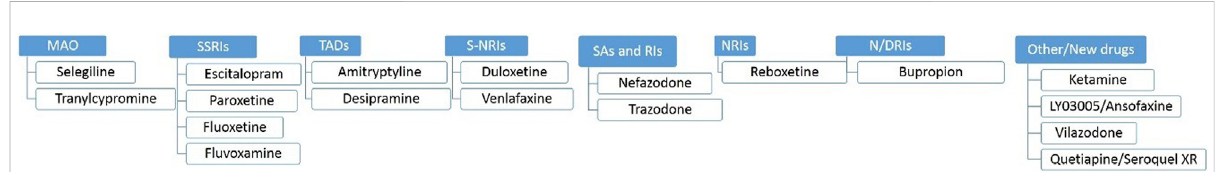
FIGURE 2 Selected examples of antidepressants by groups. MAO, Mono Amino Oxidase; SSRIs, Selective Serotonin Reuptake Inhibitors; TADs, Tricyclic Antidepressants; S-NRIs, Serotonin-Norepinephrine Reuptake Inhibitors; SAs and RIs, Serotonin Antagonist and Reuptake Inhibitors; NRIs, Norepinephrine Reuptake Inhibitors; N/DRIs, Noradrenaline and Dopamine Reuptake